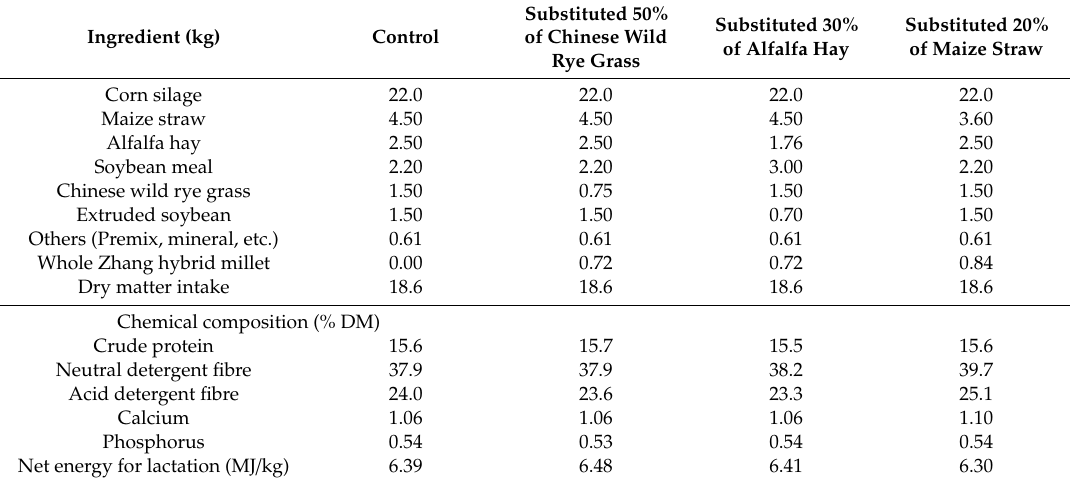
Table 2. Ingredients and chemical composition of dietary treatments (DM